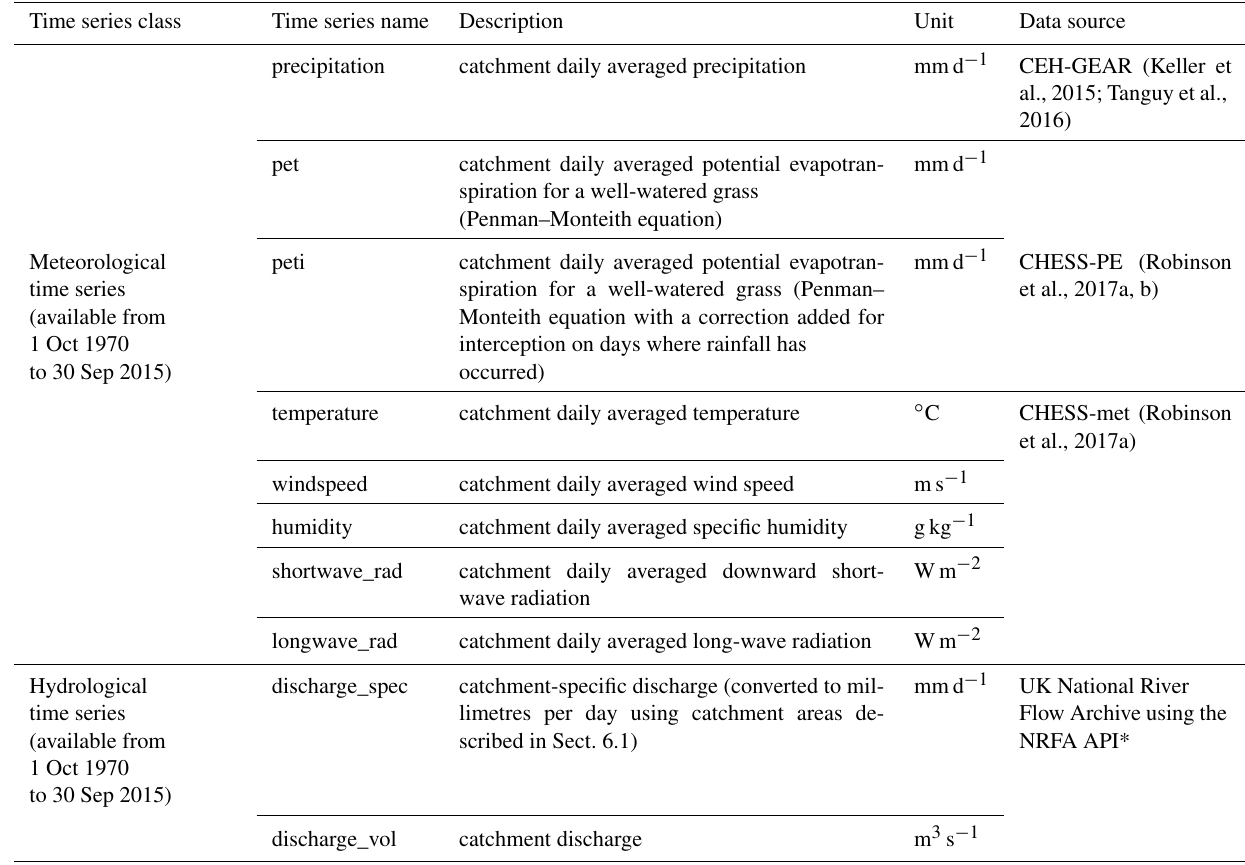
Table 1. Summary table of catchment hydro-meteorological time series available in